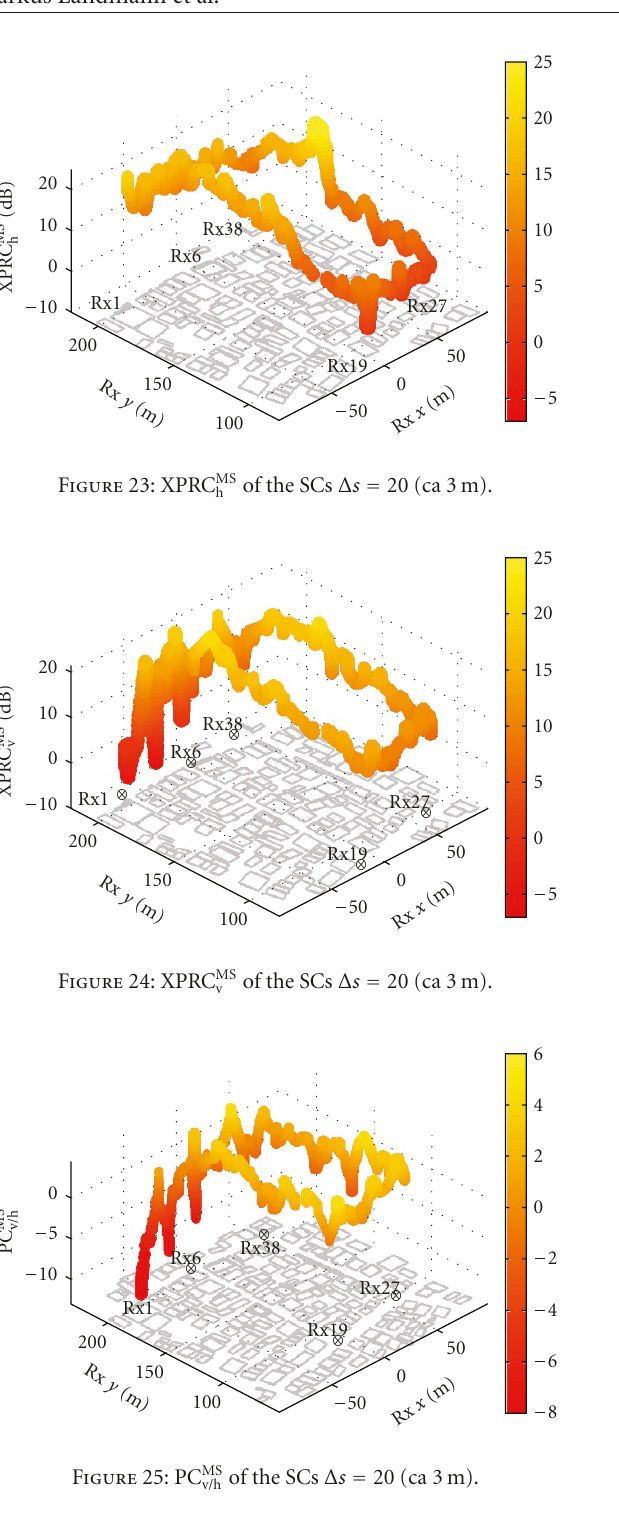
these pathweights, resulting in higher variances. Therefore, especially in the NLOS cases, which causes higher variances we used the relative error, which is the ratio between the of the estimated pathweigths. The remaining 25% (39% for XPRC and the corresponding error. Around 75% of all po- XPRC MS ) of the values have an error worse than − 10dB. In h sitions have an XPRC MS these cases with larger errors, closely spaced paths could be (61% for XPRC MS ) with a relative v h observed. As the resolution and the SNR are limited, the vari- error better than − 10dB. The di ff erence between h and v can ance of the parameters be explained by the lower total power in the h polarization